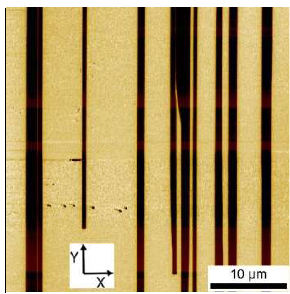
Figure 6. The domain streamers visualized by piezoresponse force microscopy (PFM) after partial polarization reversal in external field 4.8 kV/mm.